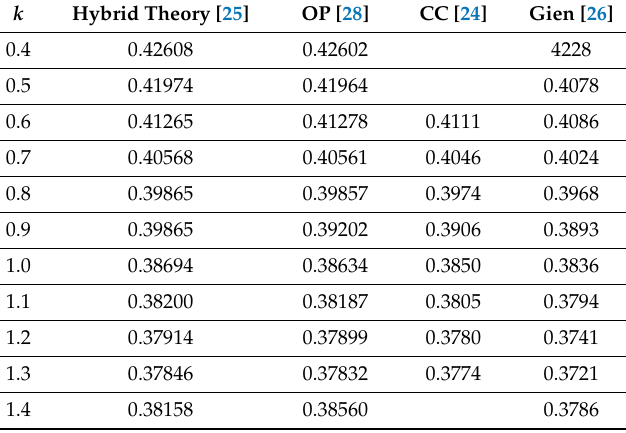
Table 3. Comparison 1 S phase shifts (radians) for electron—He + scattering with those obtained using close-coupling (CC) [24], the hybrid theory [25], those obtained by Gien [26,27] using the Harris–Nesbet method, and Feshbach projection operator formalism (OP)